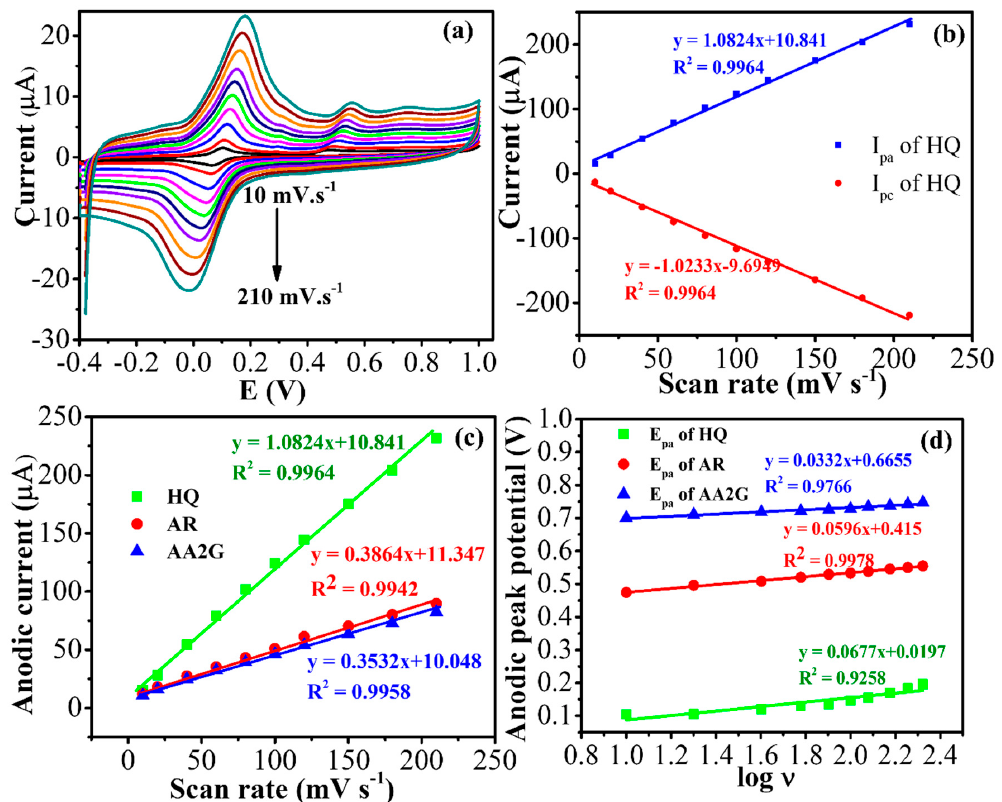
Figure 4. ( a ) CVs of the Ag@AgCl/Ag 2 S/CNTs/GCE in phosphate buffer, pH 7 containing HQ (18.2 μ M), AR (7.35 μ M), and AA2G (5.91 μ M) of all analytes at different scan rates: 10 to 210 mV ⋅ s − 1 ; ( b )